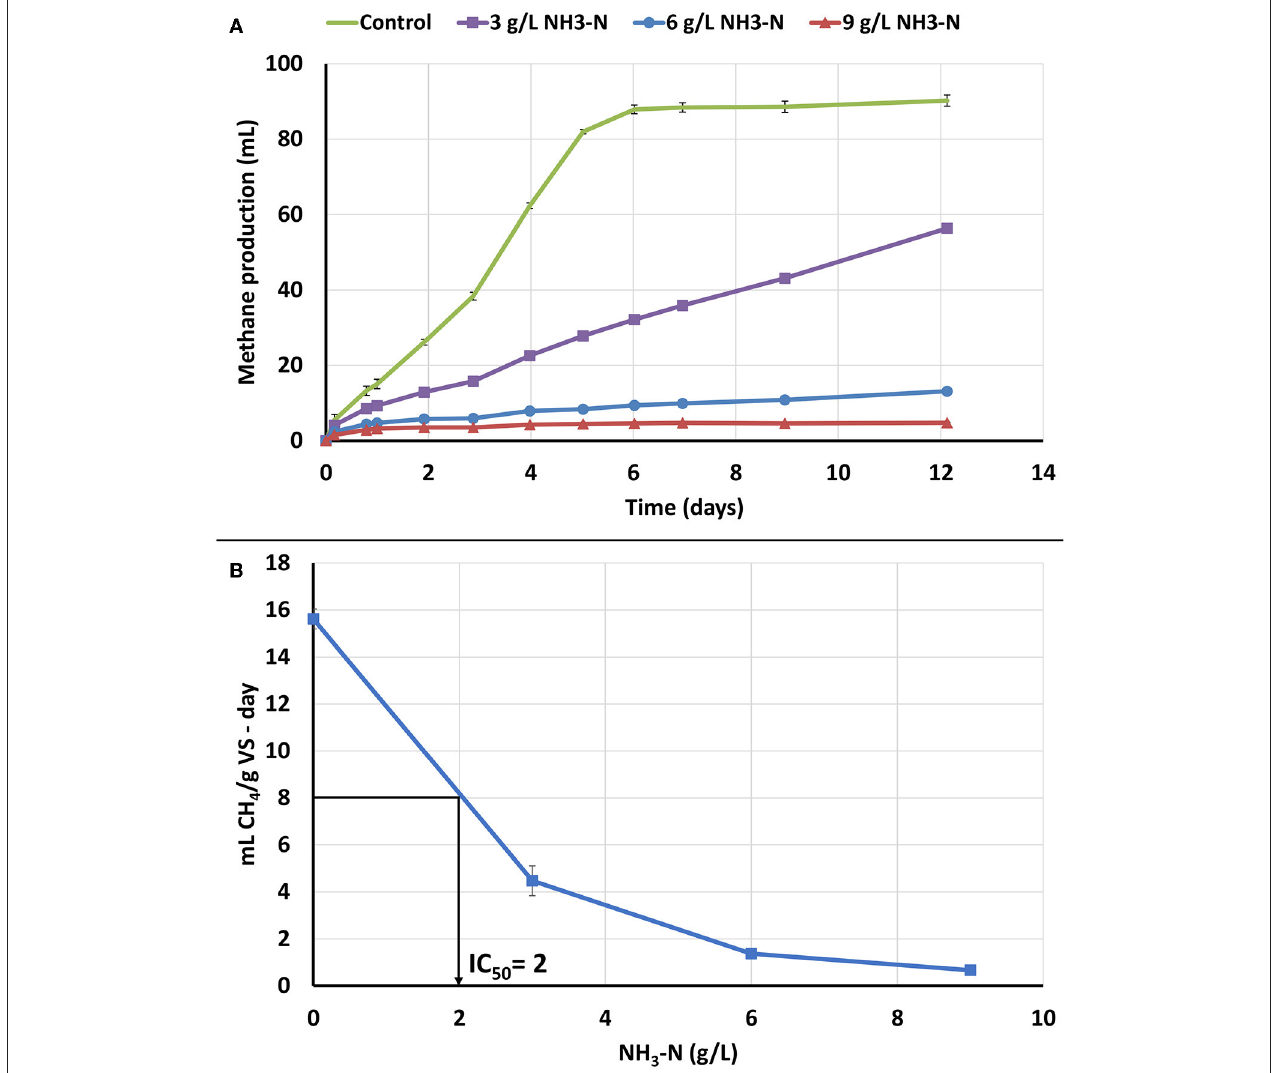
FIGURE 2 | NH 3 -N ATA results on seed biomass. Error bars represent standard deviation among triplicates. (A) Cumulative methane production. (B) ATA dose response curve for NH 3 -N ATA and IC 50 value of NH 3 -N to the seed